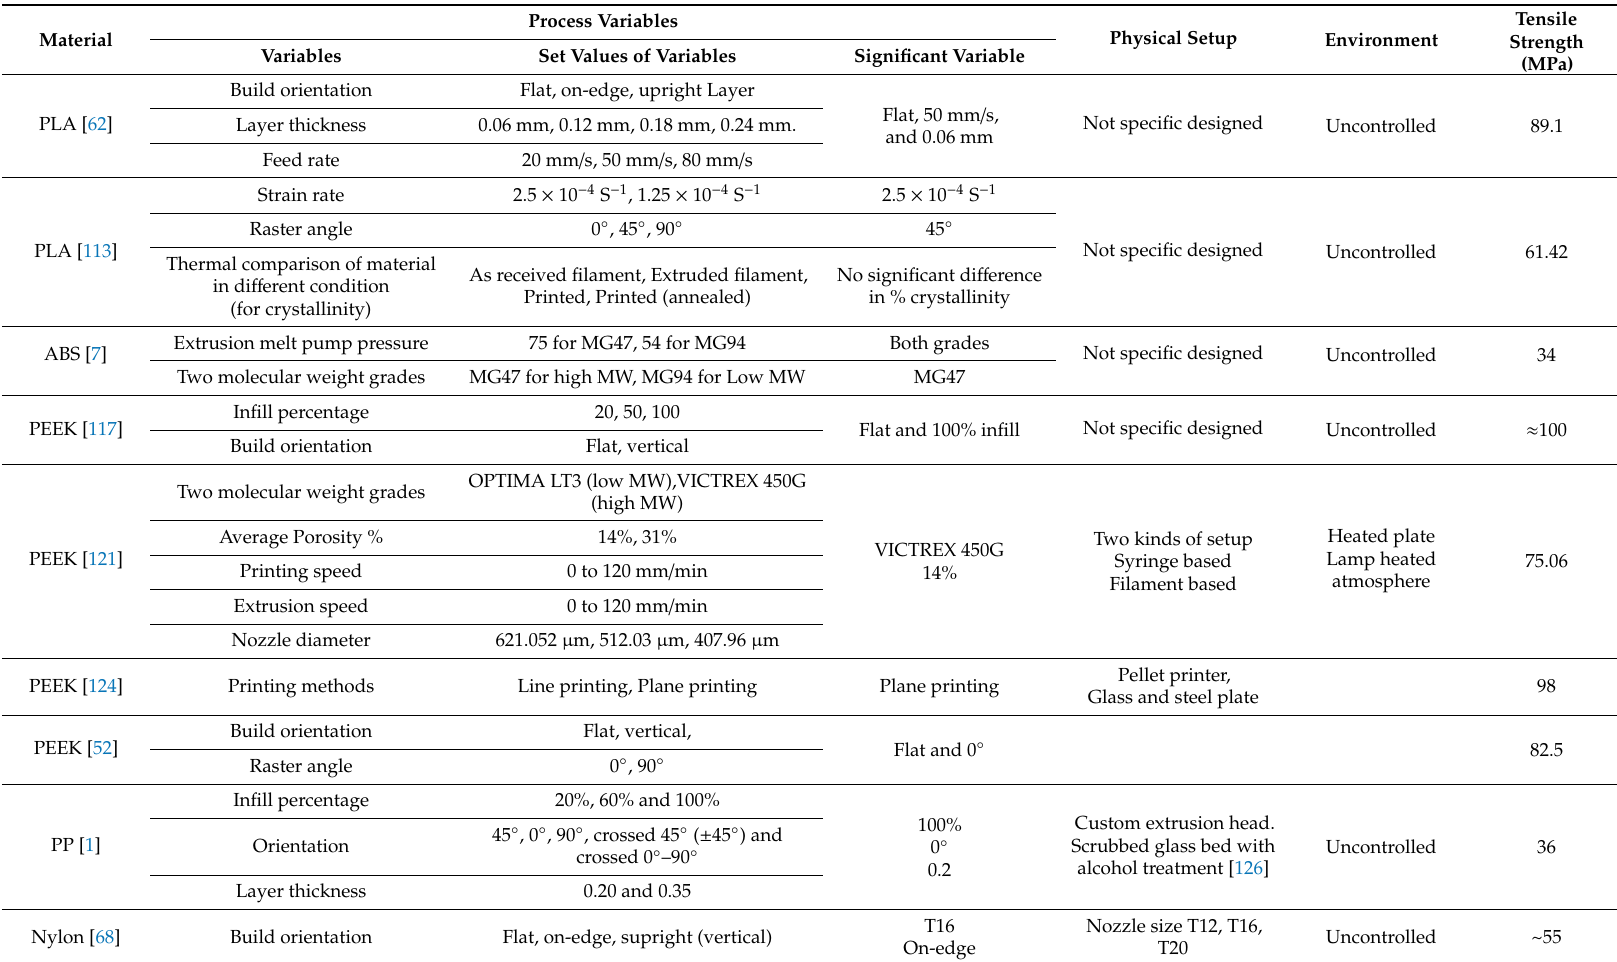
Table 2. Process factors for achieving high tensile strength of di ff erent single